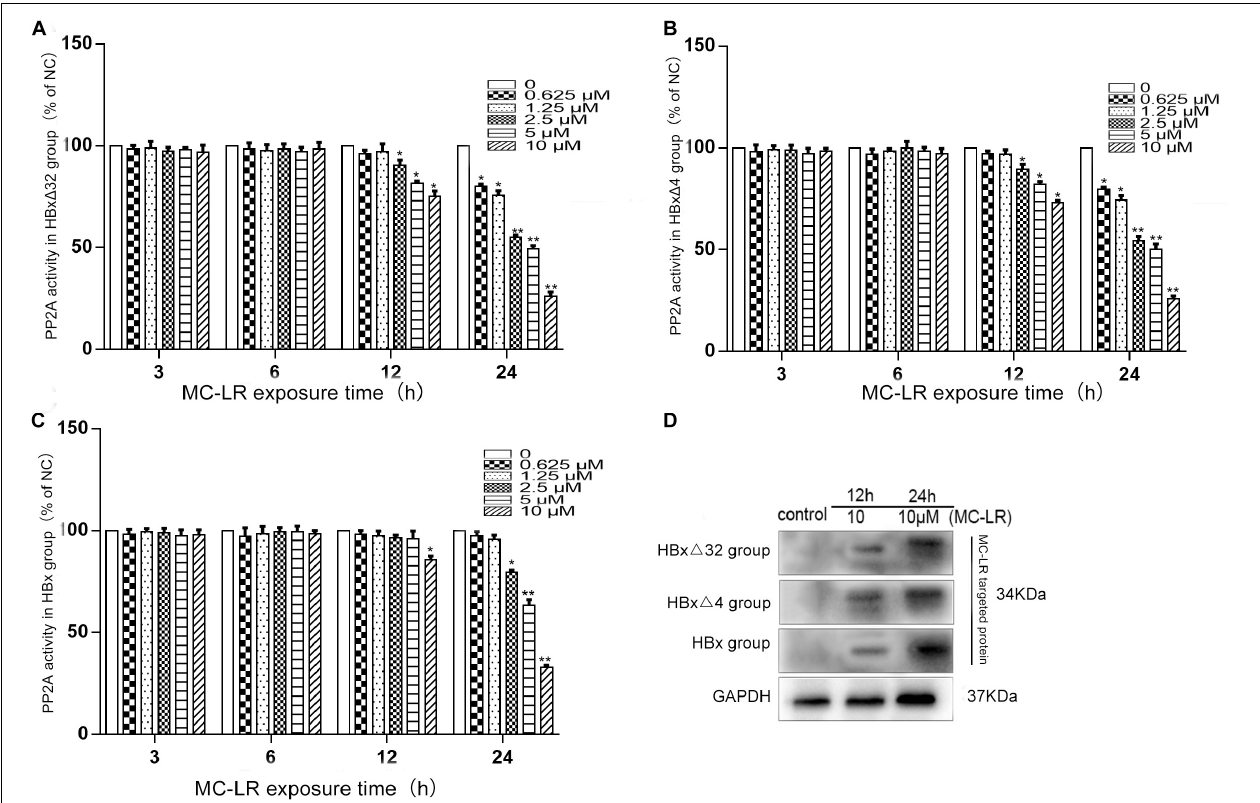
FIGURE 2 | The alteration of PP2A activity in HepG2 cells after MC-LR exposure. The HBx (cid:49) 32, HBx (cid:49) 4, HBx, and NC transfected HepG2 cells were treated with MC-LR at various concentrations, and the PP2A enzyme activity were examinated by ELISA after 3, 6, 12, and 24 h. The results showed that the PP2A enzyme activity in HBx (cid:49) 32 (A) and HBx (cid:49) 4 (B) groups both began to decrease when MC-LR ≥ 2.5 µ M at 12 h and ≥ 0.625 µ M at 24 h; While in HBx group (C) , the PP2A enzyme activity began to decrease until MC-LR = 10 µ M at 12 h and ≥ 2.5 µ M at 24 h. (D) The WB assay showed that MC-LR entered HepG2 cells and targeted to putative proteins weighted 34 kDa in HBx (cid:49) 4, HBx (cid:49) 32, and HBx groups. Bar graphs indicate means ± standard deviation from three independent experiments. * P < 0.05, ** P < 0.01 vs. 0 µ M MC-LR (Complete DMEM medium, the same as